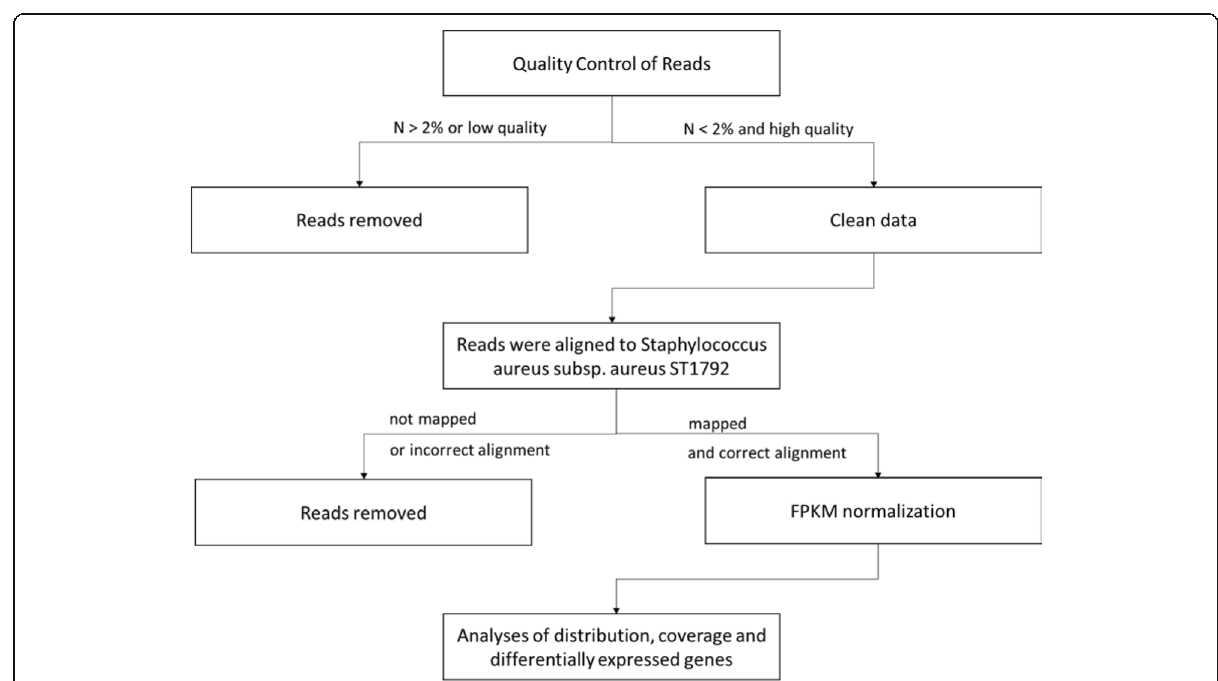
Fig. 1 Workflow of transcriptome assembly and annotation for Staphyloccocus aureus